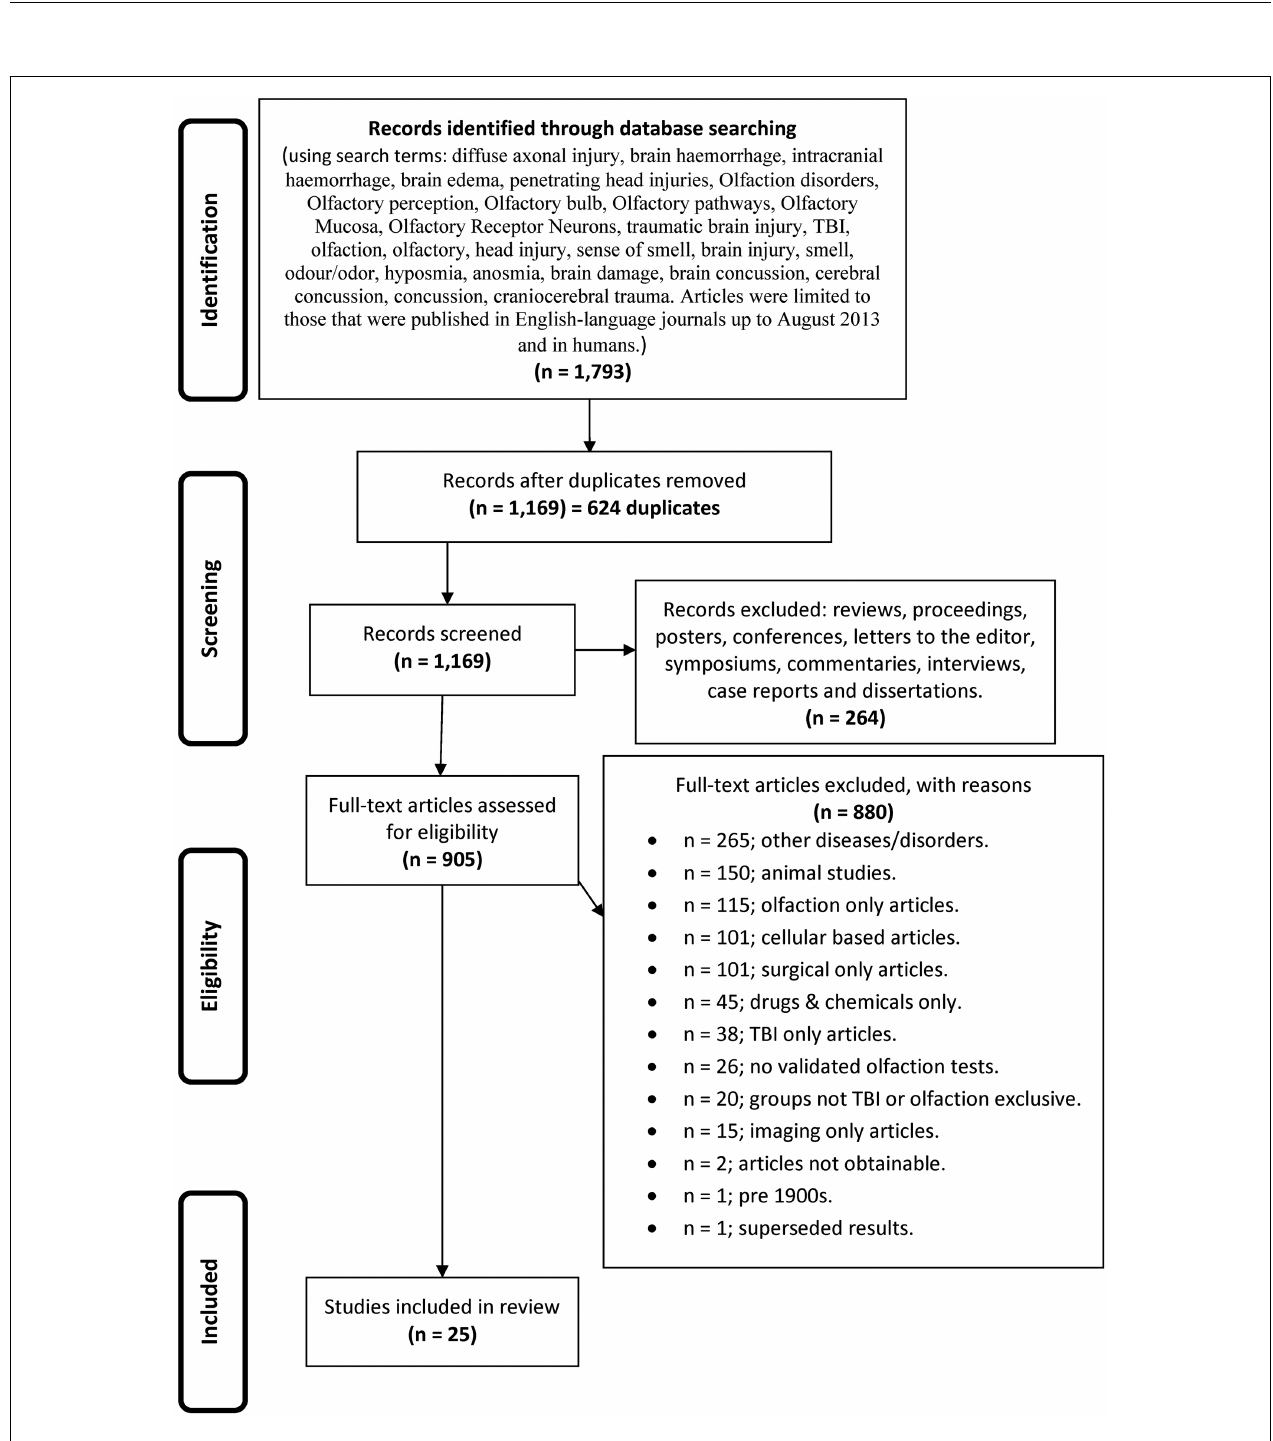
FIGURE 1 |The flow diagram depicting the search strategy, process, and exclusionary criteria by which the studies were selected for inclusion in this systematic review .